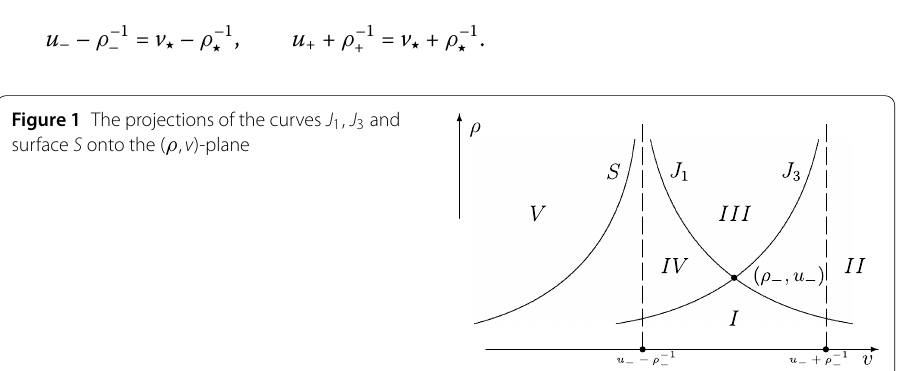
Figure 1 The projections of the curves J 1 , J 3 and surface S onto the ( ρ , v